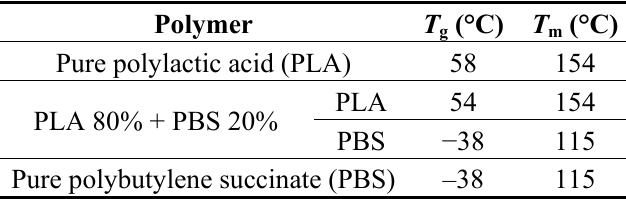
) and melting point ( T g